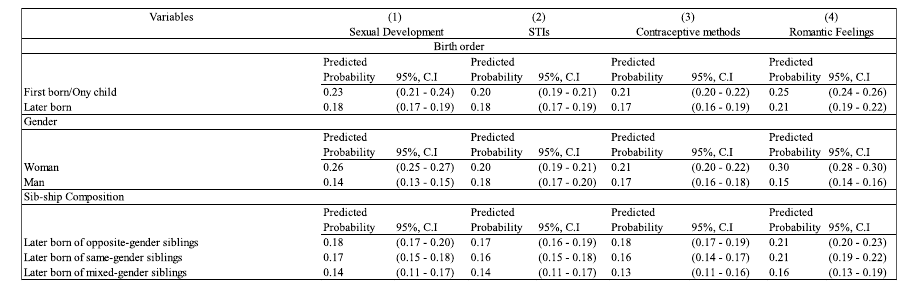
Table 4 : Predicted Probabilities